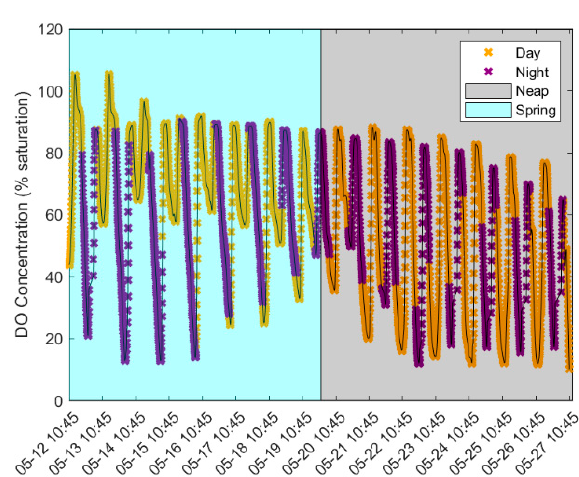
Figure 4. Sample time series of percent (%) saturation of dissolved oxygen at Site B over a period of 15 days. Daylight hours (x) begin at 6:00 a.m. and end at 8:00 p.m. and non-daylight hours (x) range from 8:00 p.m. to 6:00 a.m. Regions of light blue denote times during spring tide while the grey denotes periods of neap tide.